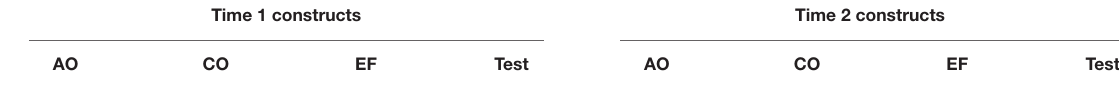
TABLE 3 | Standardized factor